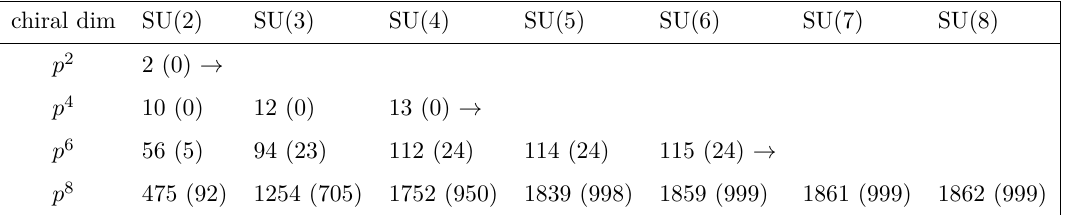
Table 8 . Enumeration of both C -even and P -even operators in the chiral Lagrangian with 2 ≤ N f ≤ 8 light quarks ( SU( N f ) unbroken symmetry). Numbers not in parentheses count non-anomalous operators (i.e. excluding operators which involve an (cid:15) µνρσ ), while numbers in parentheses count only the anomalous operators. The arrow ‘ → ’ denotes that the entry is repeated to complete the row. For P -odd Hilbert series, the above logic is reversed — epsilon terms must have an even number of intrinsic parity odd fields, and the plus sign in eq. (4.4) gets replaced by a minus